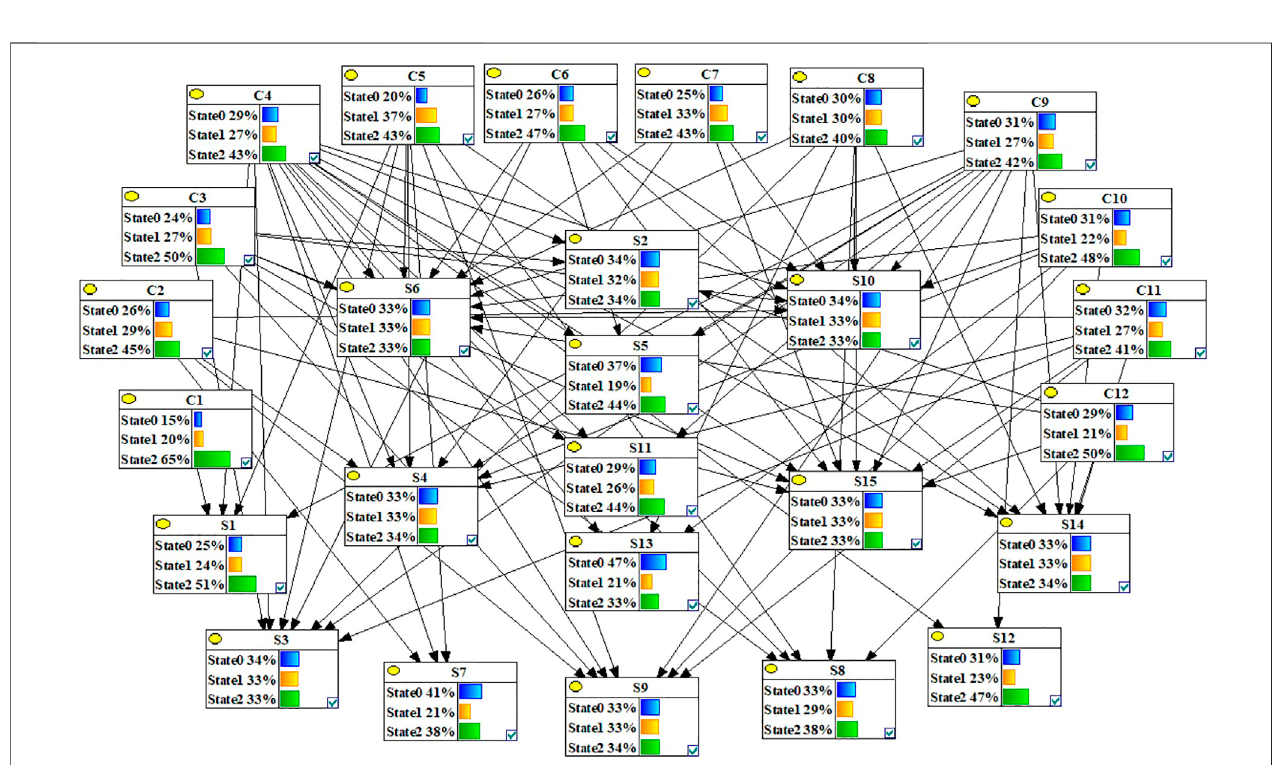
FIGURE 4 | Parameter learning results of the case